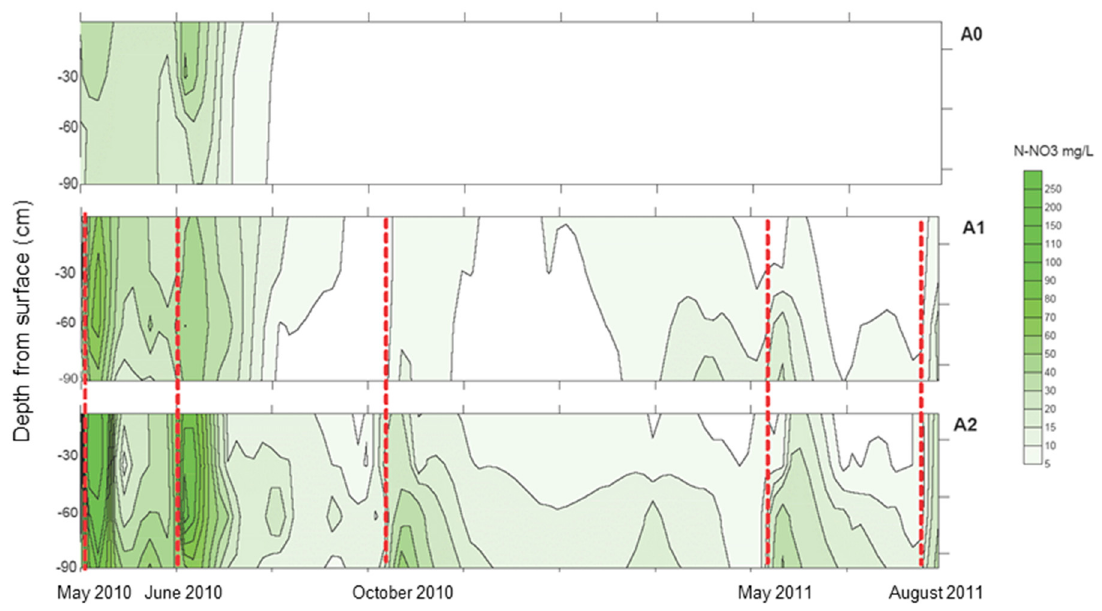
Figure 2. Contour plot of the N-NO 3 concentration in the 0–90 cm soil horizon obtained via Kriging interpolation method during the monitored period in SRF plots ( A0 – A2 ). The dashed red lines are the digestate spreading dates.